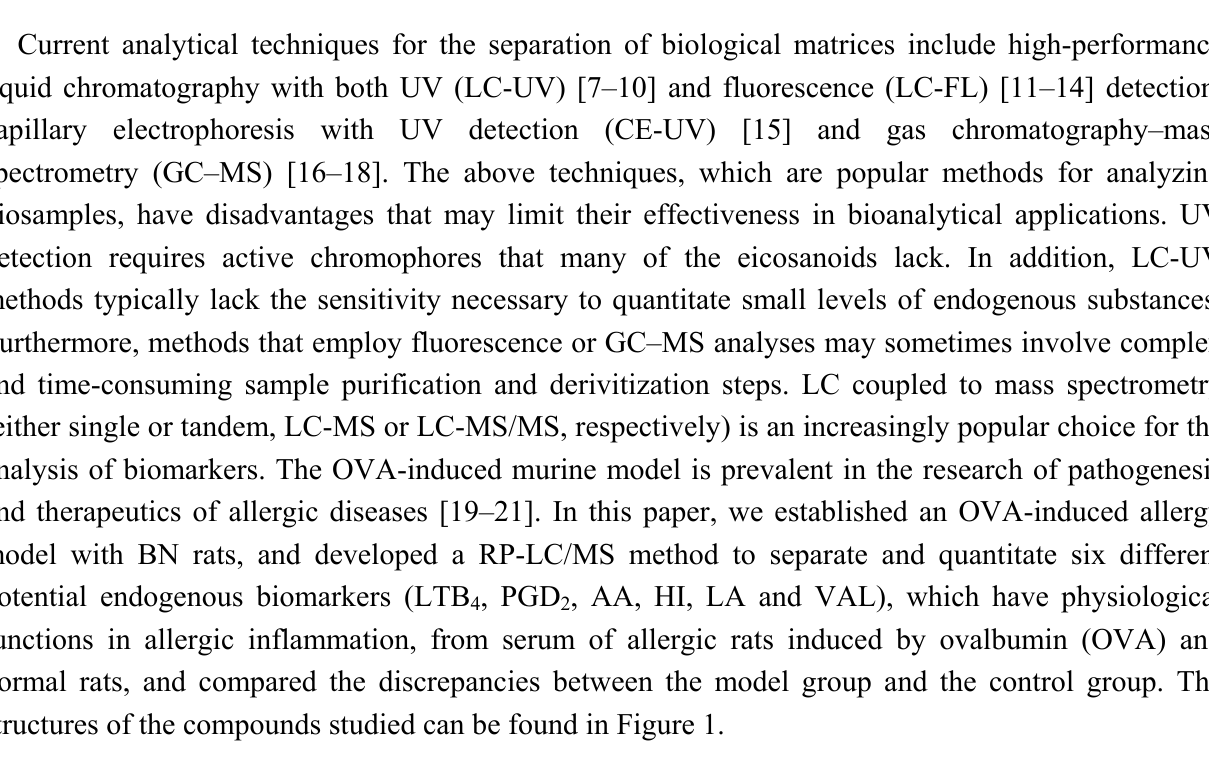
Figure 2. Representative total ion chromatograms (TIC) of the serum from the OVA- induced rat obtained in negative (A) and positive (B) ion electrospray. The retention time is 5.9 min, 34.5 min and 52.5 min for LA, PGD mode, and the retention time is 5.3 min, 6.0 min and 34.1 min for VAL, HI and LTB respectively in positive ion